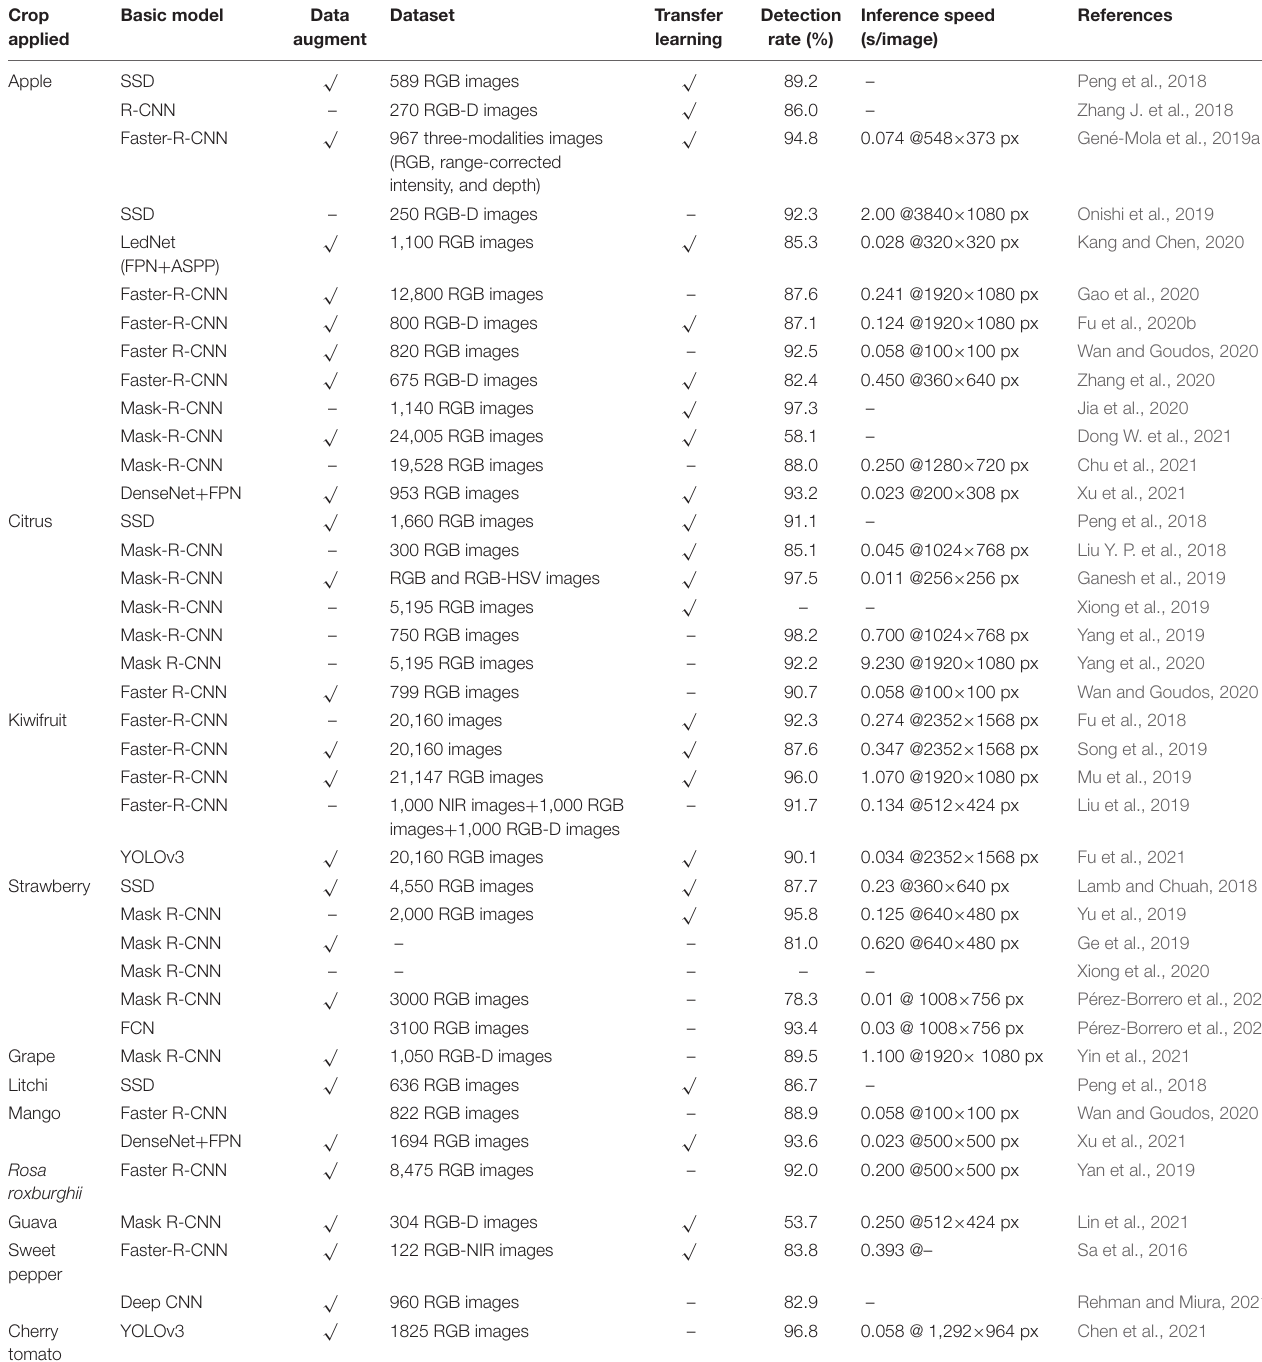
TABLE 6 | Summary of related studies on application of CNN-based detection models in fruit